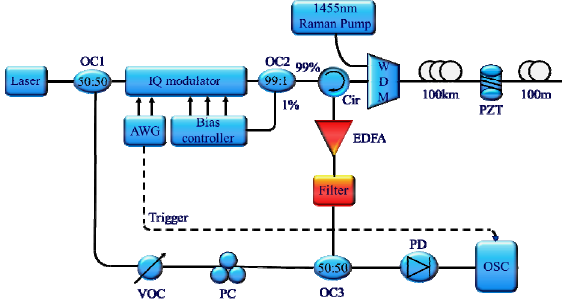
Fig. 13 Experimental setup of 100 km DAS system based on coherent detection [39].